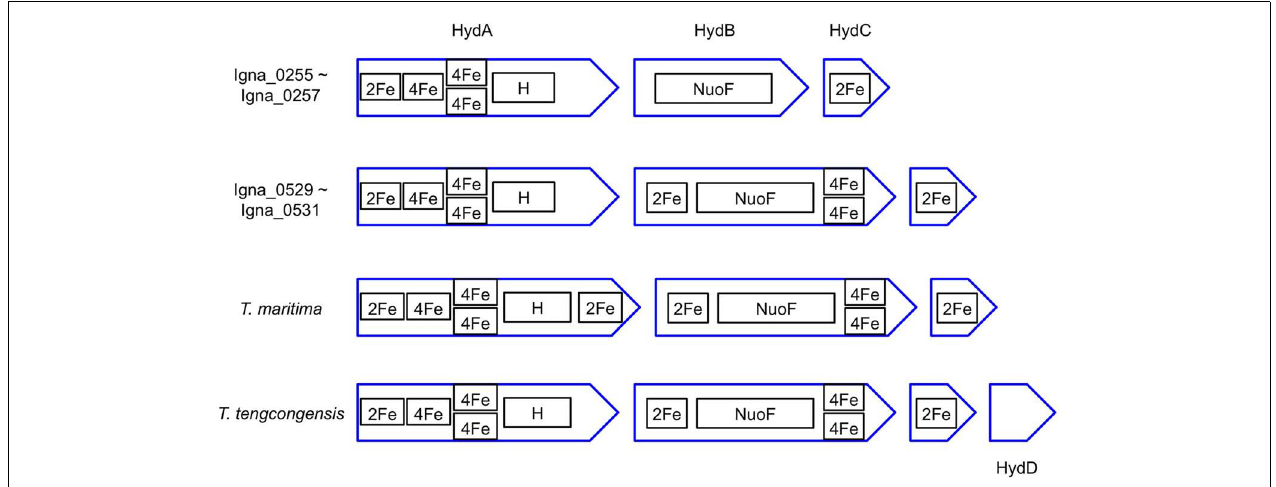
FIGURE 9 | Schematic representation of the predicted Fe/S cluster contents of two hydrogenases from I. album compared to two related and experimentally characterized hydrogenases from Thermotoga